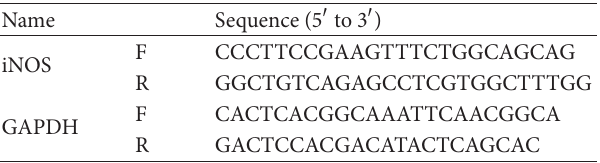
Table 1: Primer sequences used for real-time PCR